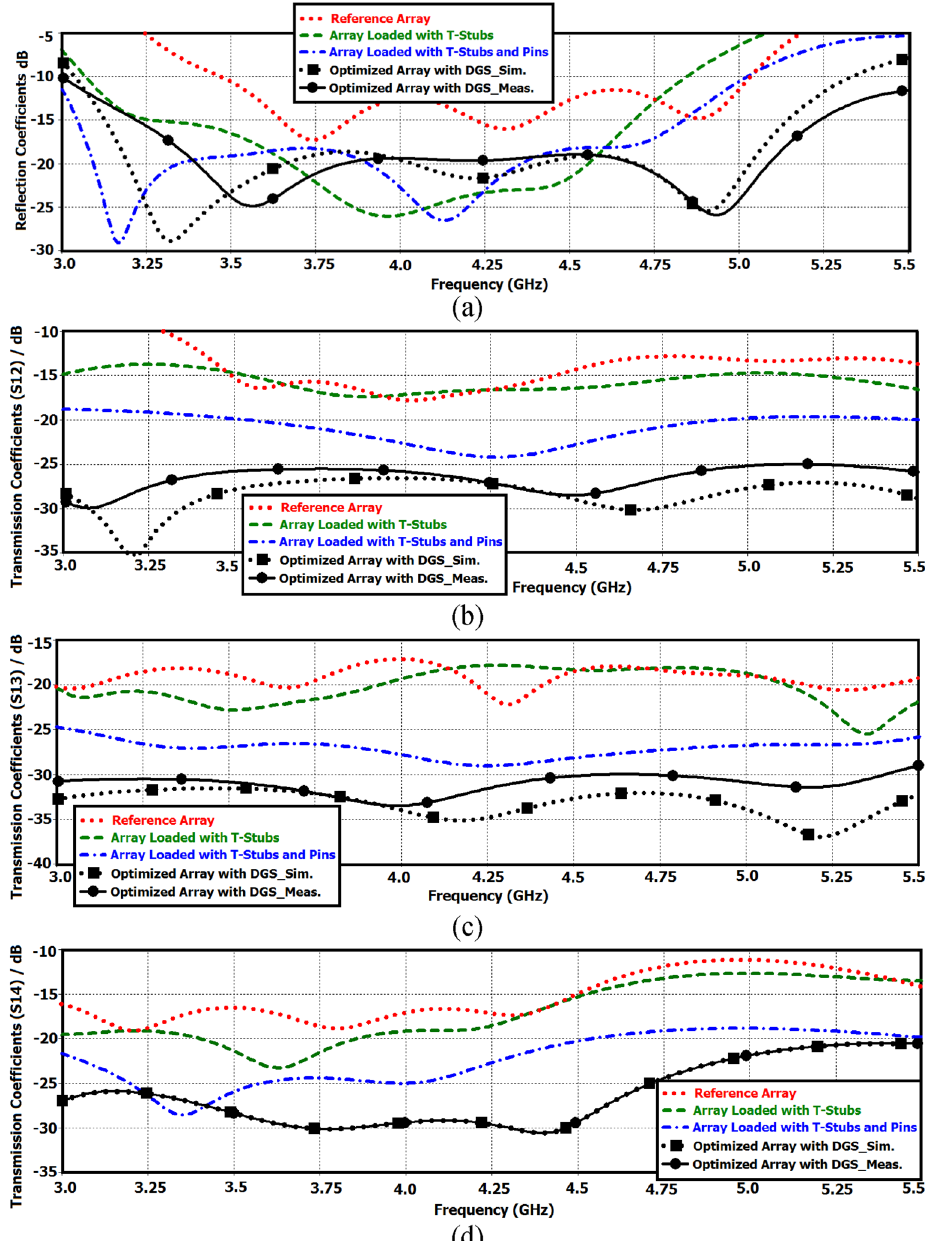
( S 12 ) between antennas #1&2, ( c ) transmission coefficient ( S 13 ) between antennas #1&3, and ( d ) transmission coefficient ( S 14 ) between antennas between antennas